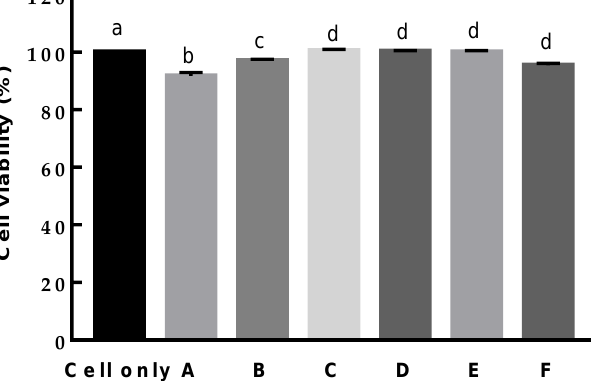
Figure 9. Viability of RAW 264.7 cells after treatment with L. paracasei EPS DA-BACS. A, 1.0 × 10 9 CFU/mL; B, 5.0 × 10 8 CFU/mL; C, 1.0 × 10 8 CFU/mL; D, 5.0 × 10 7 CFU/mL; E, 1.0 × 10 7 CFU/mL; F, 1.0 × 10 6 CFU/mL. Different letters show significant differences among groups at p < 0.05 ( n ≥ 3) using one-way ANOVA and Duncan’s test. inflammatory activity of heat-treated L. paracasei EPS DA-BACS on RAW 264.7 macrophage